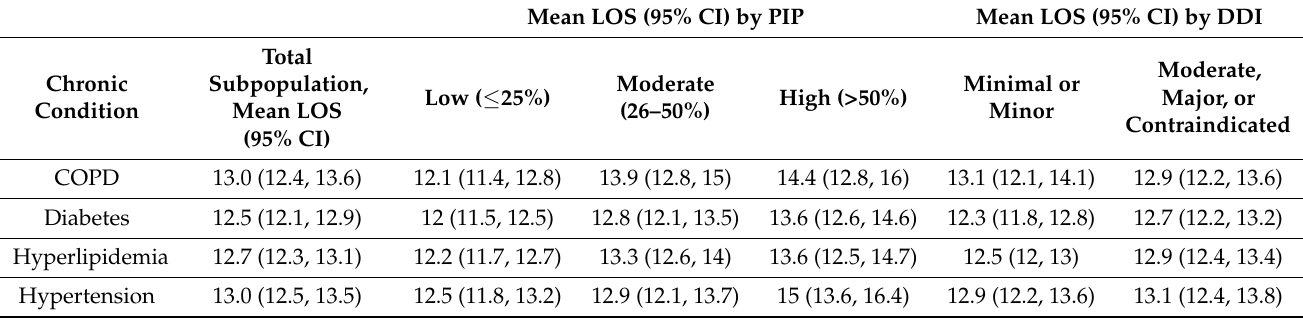
Table 3. Distribution of length of stay among patients hospitalized with COVID-19 by chronic condition and pharmacoge- nomic or drug–drug interaction